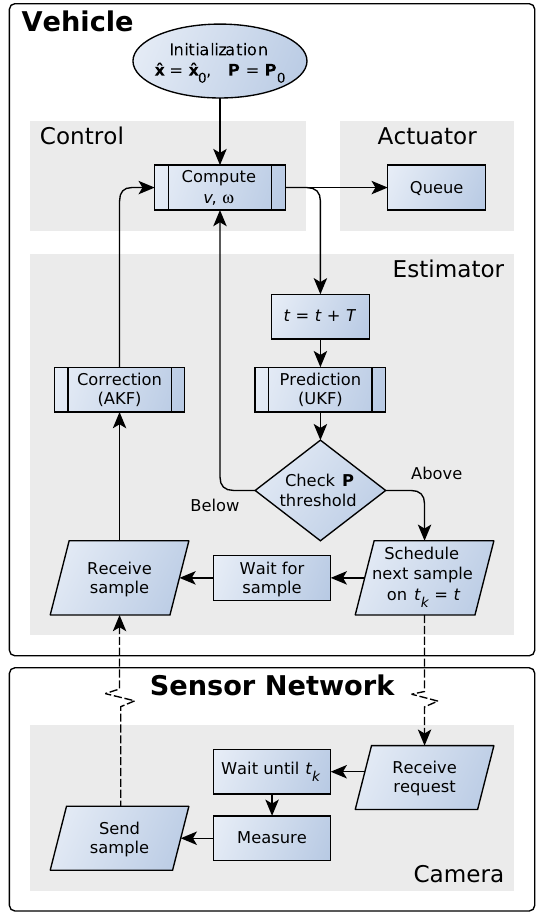
Figure 2. Flowchart of the event-based state estimator (EBSE), executed by the vehicle and the